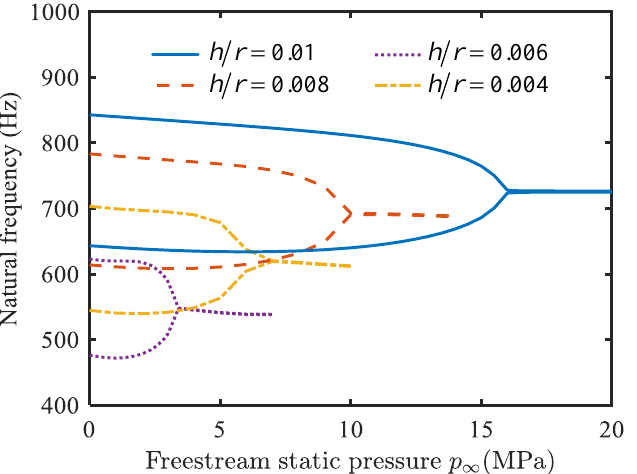
Figure 9. Influence of the thickness-to-radius ratio of the conical shell on critical free-stream static pressure ( p = 1).